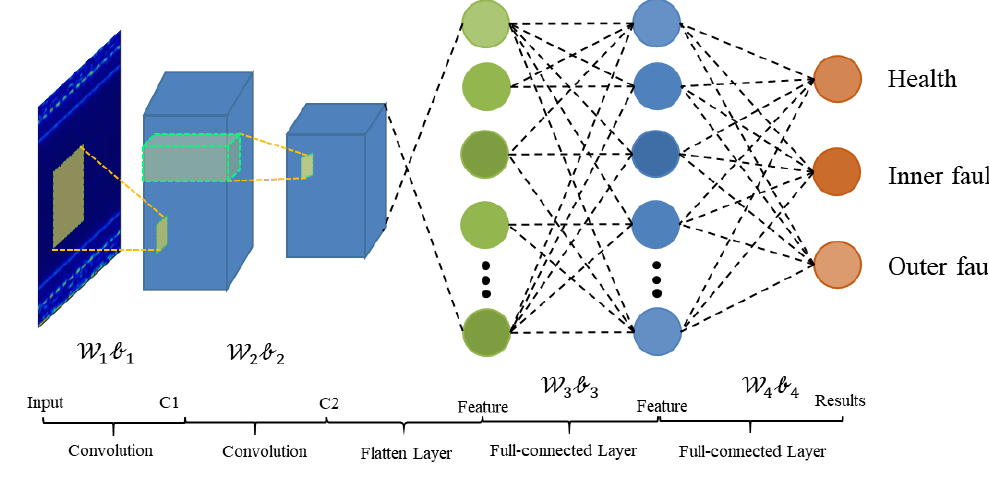
Figure 4. Architecture of WDA.